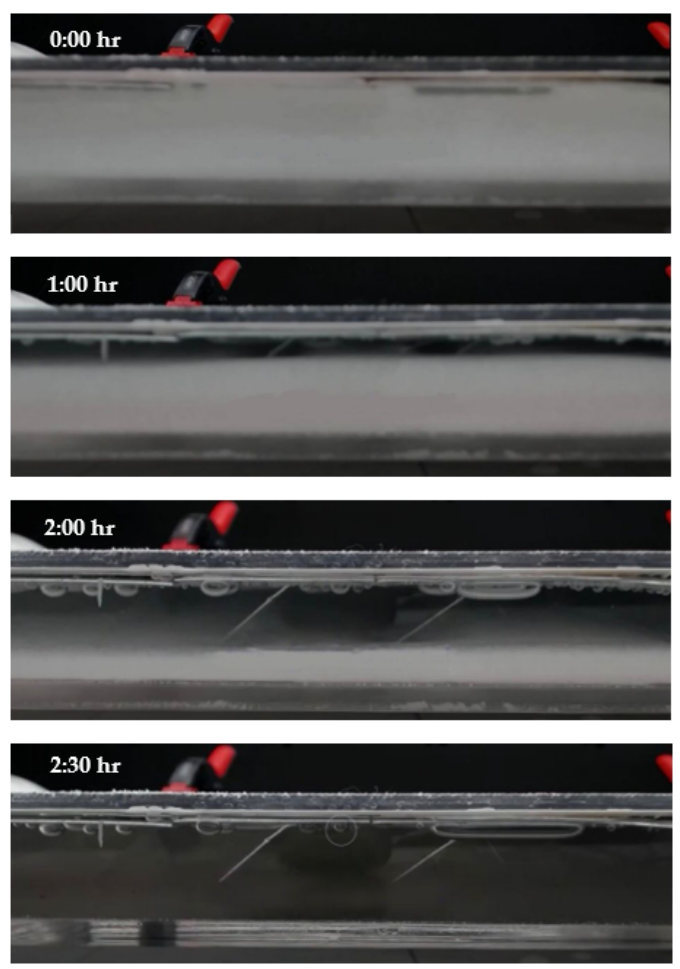
Figure 9. Photo sequence of the melting process.